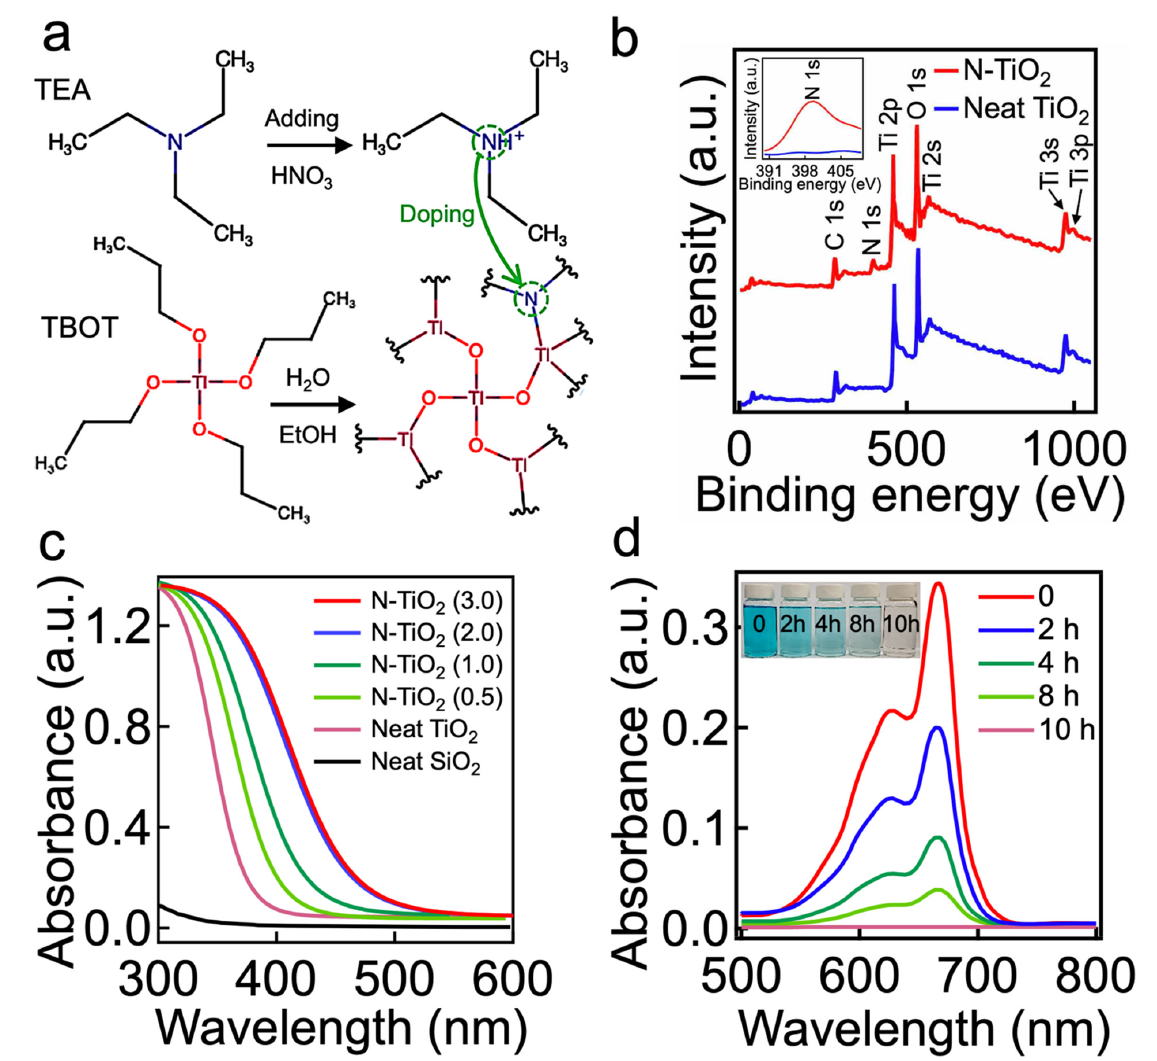
Figure 1. ( a ) Schematic illustrating the synthesis of N-TiO 2 nanoparticles by utilizing titanium butoxide (TBOT) and triethylamine (TEA) as a TiO 2 precursor and nitrogen dopant, respectively. ( b ) The XPS spectrum of N-TiO 2 , exhibiting characteristic peaks of N 1s, Ti 2p, and O 1s. The spectrum of a neat TiO 2 is also shown for comparison. The inset shows the core level spectrum of characteristic N 1s. ( c ) Ultraviolet–visible (UV-Vis) absorption spectra of N-TiO 2 synthesized by varied molar ratios of TEA to TBOT (e.g., 0.5, 1.0, 2.0, and 3.0). Neat TiO 2 and SiO 2 absorption spectra are also shown for comparison. ( d ) UV-Vis absorption spectra of water dissolved with N-TiO 2 and Solvent Blue dye as a function of the visible light irradiation time. The inset is a photograph showing the water dissolved with Solvent Blue dye after visible light irradiation for 2 h, 4 h, 8 h, and 10 h. The as-prepared water dissolved with Solvent Blue dye (concentration = 0.5 wt%) is also shown.